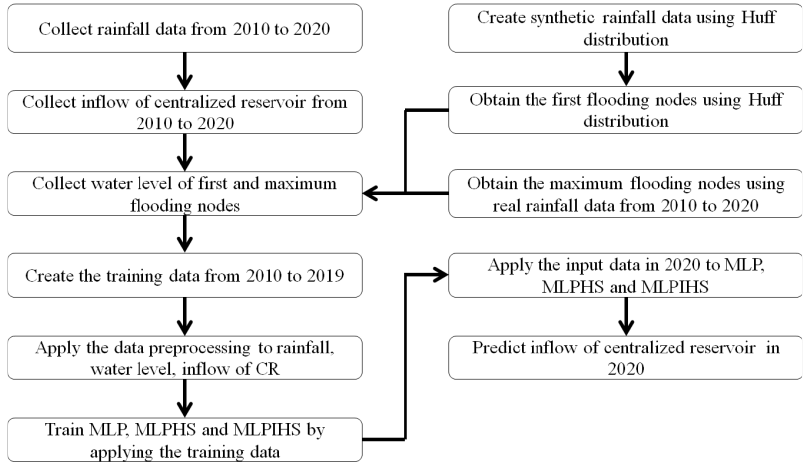
Figure 1. Workflow of this study.